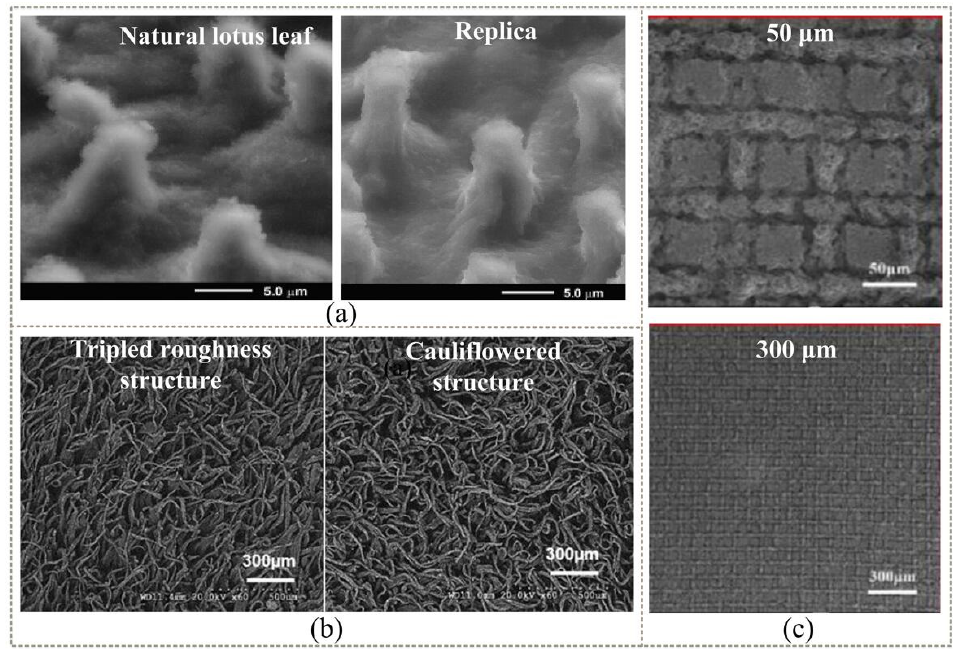
Figure 3. Preparation effects of the template method: ( a ) SEM images of the natural lotus leaf and its positive replica [53]; ( b ) SEM images of superoleophobic rough fibrous structures of high–density polyethylene (HDPE) [65]; ( c ) SEM images of the flexible tube [66].